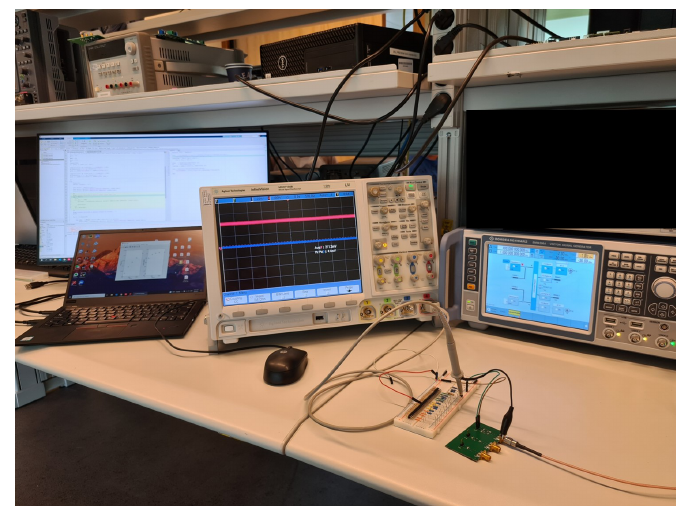
Figure 7. Picture of the measurement setup. The measured output DC voltage and power with one- and two-stage multipliers are shown in Figures 8 and 9, respectively. The voltage and power are plotted against the load resistance with different tone amplitude V A . During measurement, V A is measured at the central pin of the SMA connector on the PCB using a Teledyne LeCroy SDA816Zi serial data analyzer with a ZS1000 active probe with 1 GHz bandwidth. The fluctuation with the measured results with low input V A and especially low load resistance is because of the low output voltage, which is close to the digital oscilloscope’s noise floor. Despite this, the measured and simulated results are consistently in very good agreement.